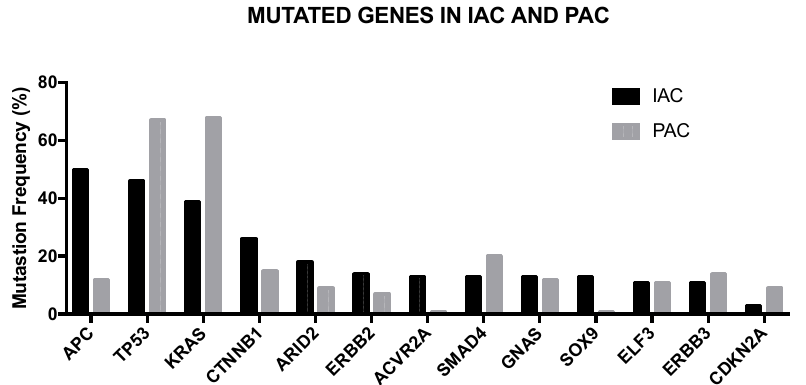
Figure 4. Frequency of the main genetic abnormalities observed in ampullary carcinomas, subdivided into intestinal-type (IAP) and pancreatobiliary-type (PAC).